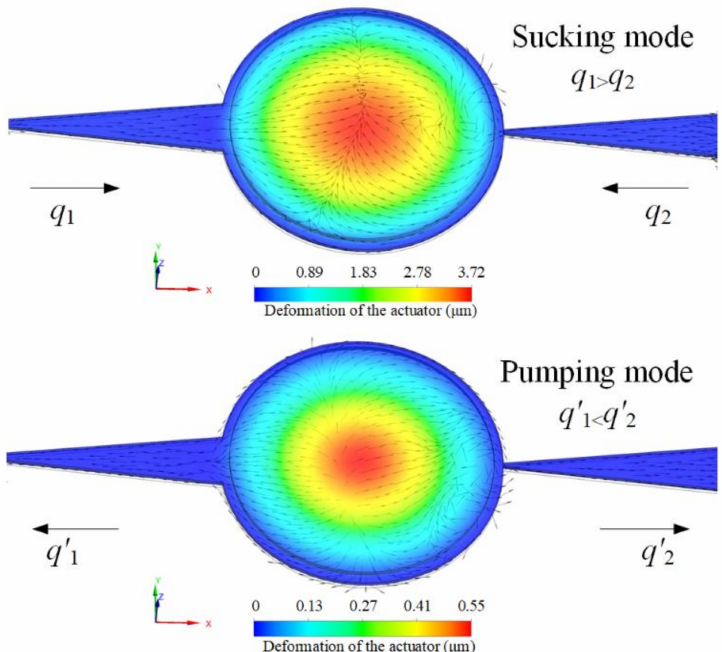
Figure 2. The working mechanism of the designed valveless piezoelectric